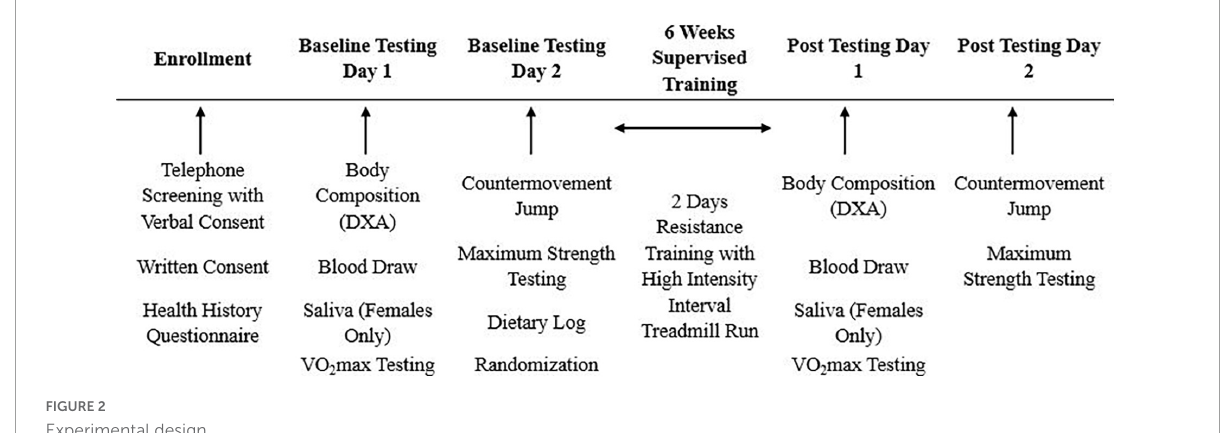
FIGURE2 Experimental design.